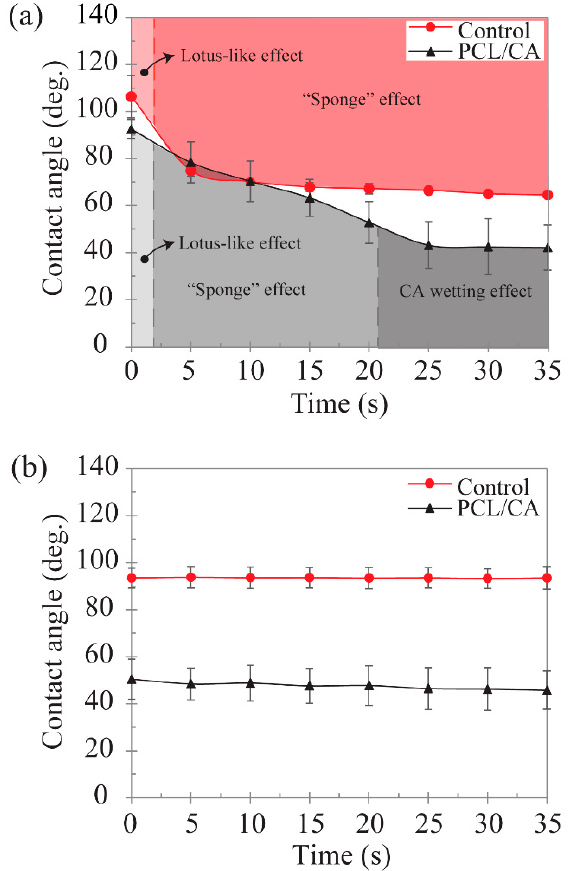
Figure 7. Time-dependent contact angle measured at the top surface of the control and PCL/CA samples: ( a ) electrospun fibrous scaffolds and ( b ) spin-coated membranes. Data points represent mean values of 3–5 measurements. Error bars represent one standard deviation above and below the corresponding mean value.